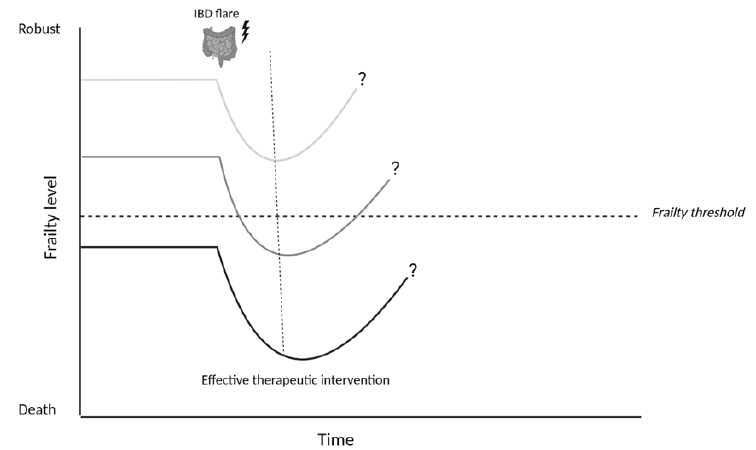
Figure 2. Hypothesized effect of an IBD flare on frailty in patients with Inflammatory Bowel Disease. An IBD flare should be considered as a potential stressor that can cause a temporary or definite decline in the degree of frailty (level). The impact of this stressor depends on the frailty level prior to the IBD flare, which consists of existing risk factors for frailty in a patient. Achieving disease remission and thereby eliminating the stressor, enables (partial) recovery of frailty levels to baseline. It is likely that this recovery phase takes longer in patients who were already frail prior to the IBD-flare, because they already had a reduced reserve capacity. Images were created using biorender.com